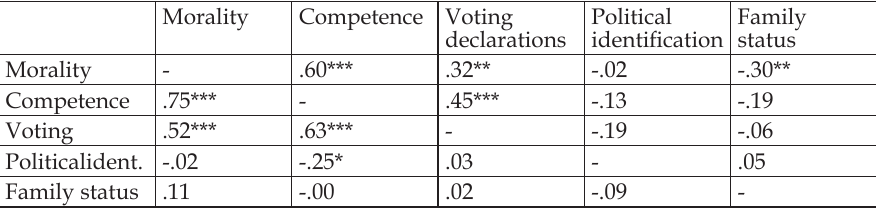
Table 2. Intercorrelations of Variables in Experiment